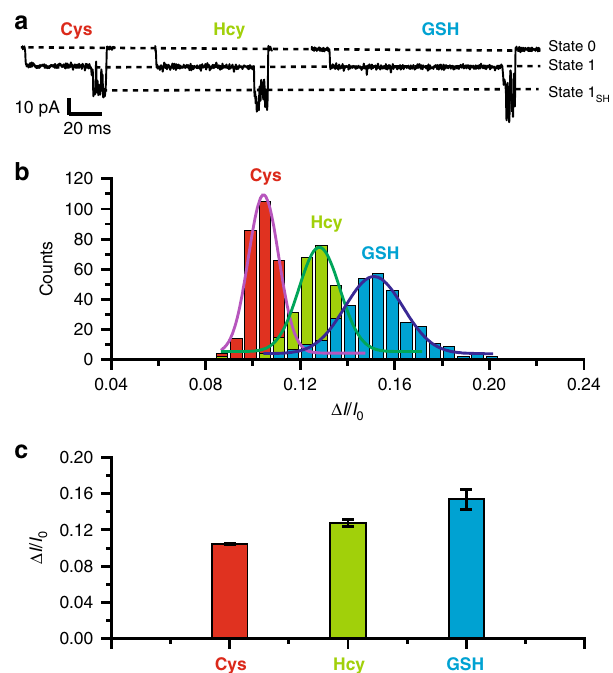
Fig. 6 Discrimination of three types of biothiols by Au(III) embedded MspA-M. a Representative binding events of Cys, Hcy or GSH acquired with Au(III) embedded MspA-M nanopore. b The histogram of Δ I / I 0 with corresponding Gaussian fi ttings from events of Cys, Hcy, and GSH. ( N = 330 for each distribution). c The bar plot of the mean Δ I / I 0 values of Cys, Hcy, and GSH. (Cys: 0.104 ± 0.0006, Hcy: 0.128 ± 0.004, GSH: 0.154 ± 0.011). All means and standard deviations were from three independent experiments for each analyte (10 min continuous recordings, Supplementary Tables 6, 8,